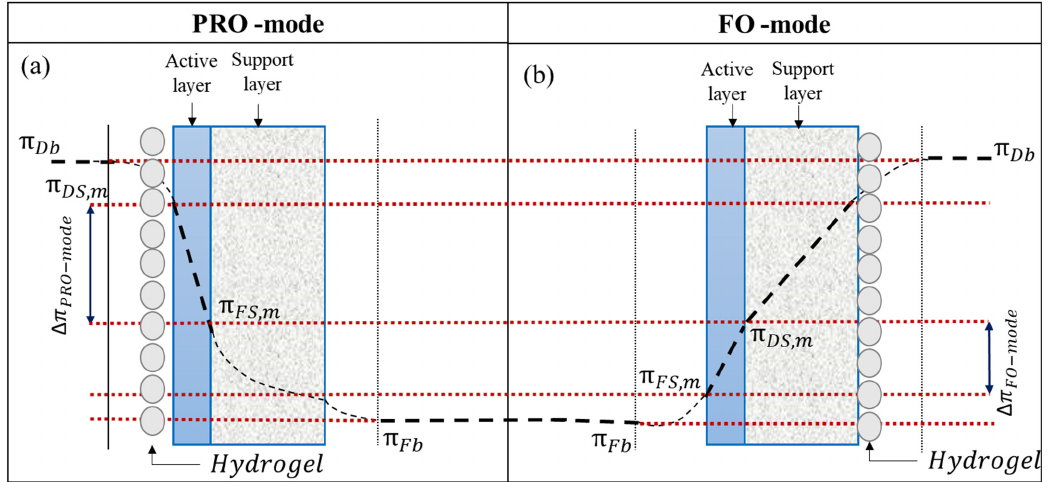
Figure 2. Solute concentration profile for ( a ) AL-DS (PRO)-mode and ( b ) AL-FS (FO)-mode [Note: osmotic pressure gradient, ∆ π = ( π DS , b − π FS , b ) and effective osmotic pressure gradient ∆ π = ( π − π ) ]. DS , m FS , m ef f